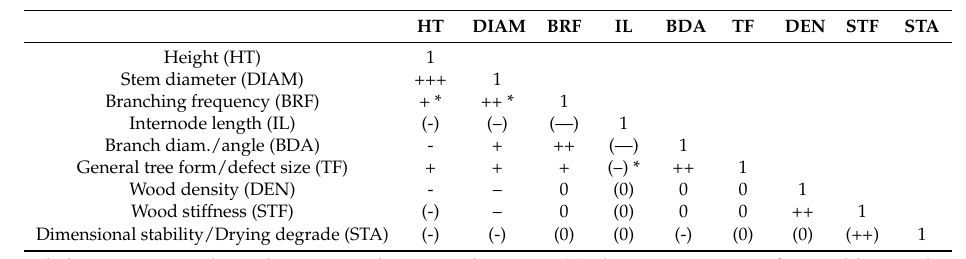
Table 4. Approximate pattern, in terms of sign and strength, of genetic correlations between traits in radiata